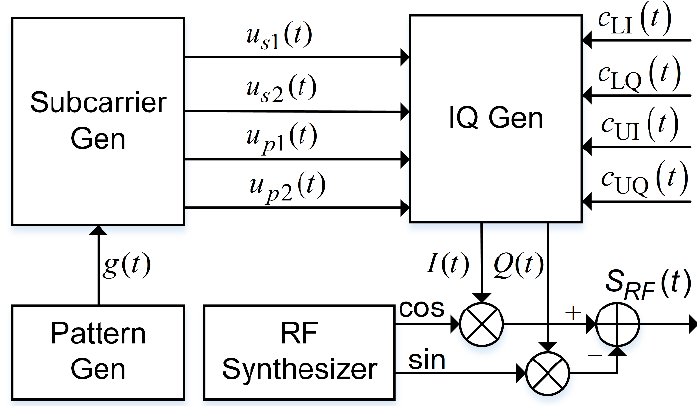
Figure 4. Direct generation with decomposed subcarriers.